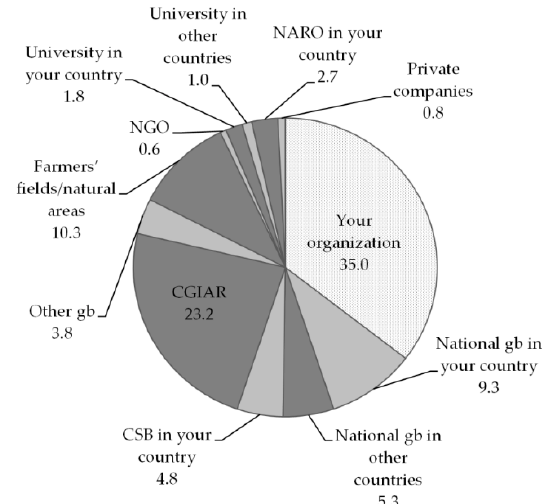
Figure 4. Sources of germplasm used by breeders. CGIAR, Consultative Group on International Agricultural Research; CSB, community seed bank; gb, genebank; NARO, National Agriculture Research Organization; NGO, non-governmental organization.